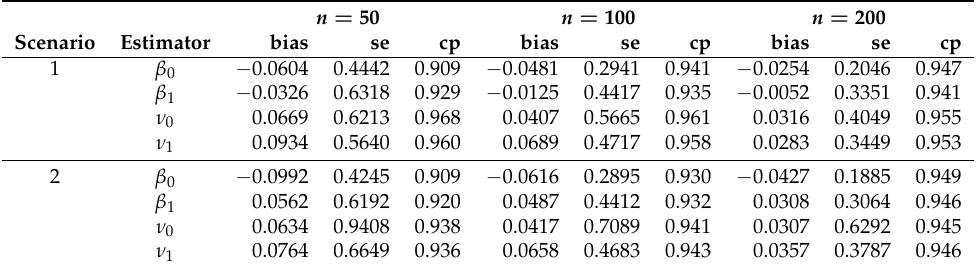
Table 1. Estimated bias, standard errors and coverage probabilities for the estimators in the reparametrized Lomax model. n = 50 n = 100 n = 200